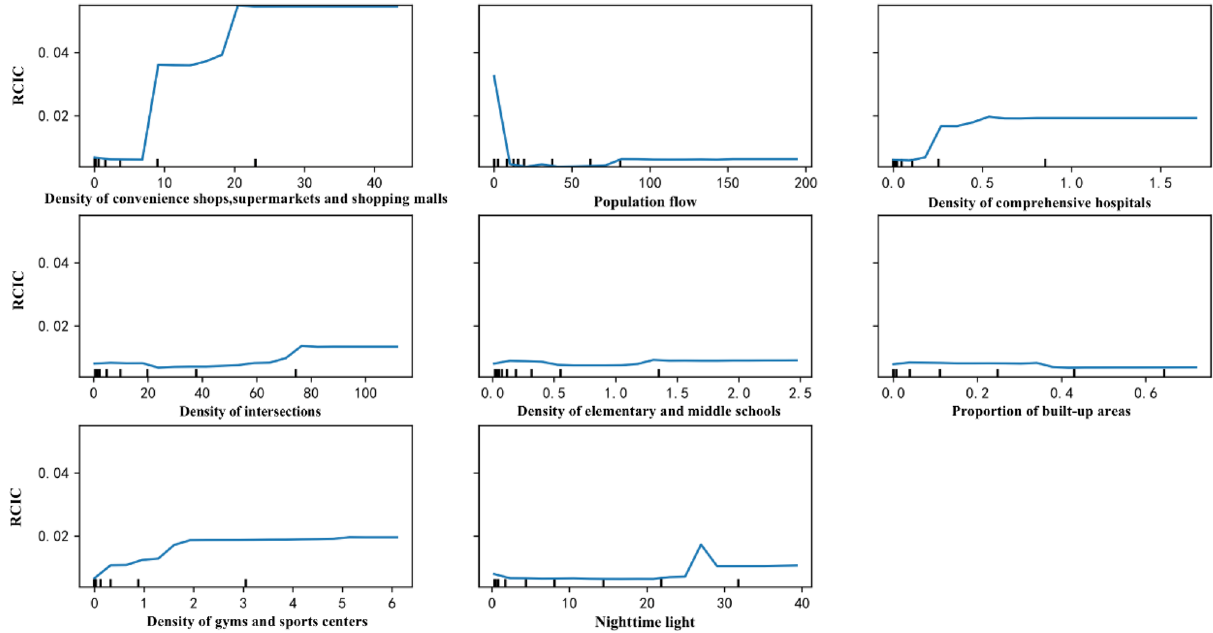
Figure 3. Partial dependence plots between built environment factors and the RCIC. Created using Anaconda Navigator Version 1.9.12 from Anaconda (https:// www. anaco nda.